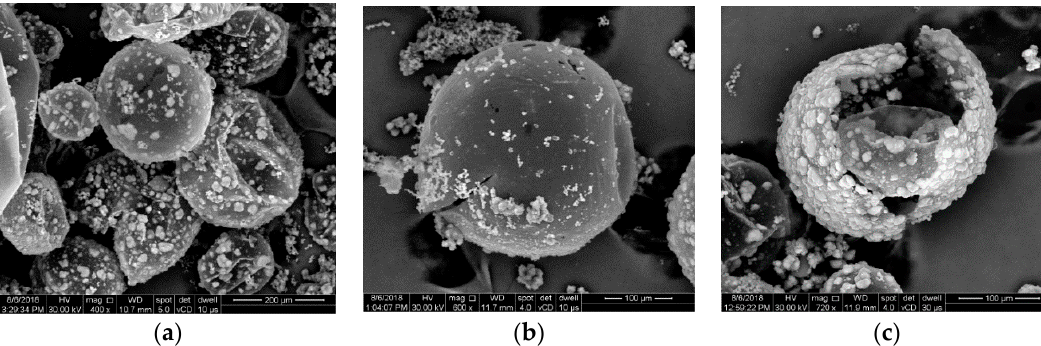
Figure 5. Optical images illustrating ( a ) microcapsules after 24 h drying at room temperature—25× zoom and ( b ) microcapsule dimensions—45× zoom (one division represents 100 µm).